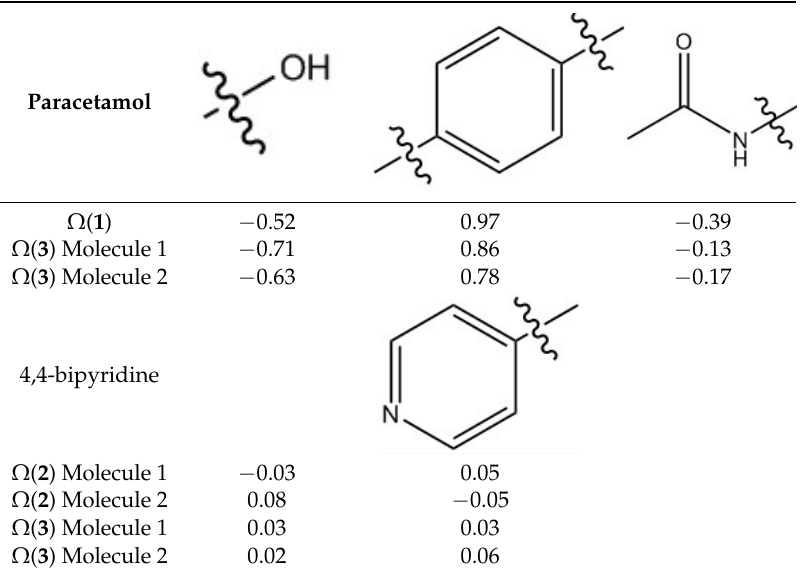
Table 3. Atomic charges (e) from multipole refinement.